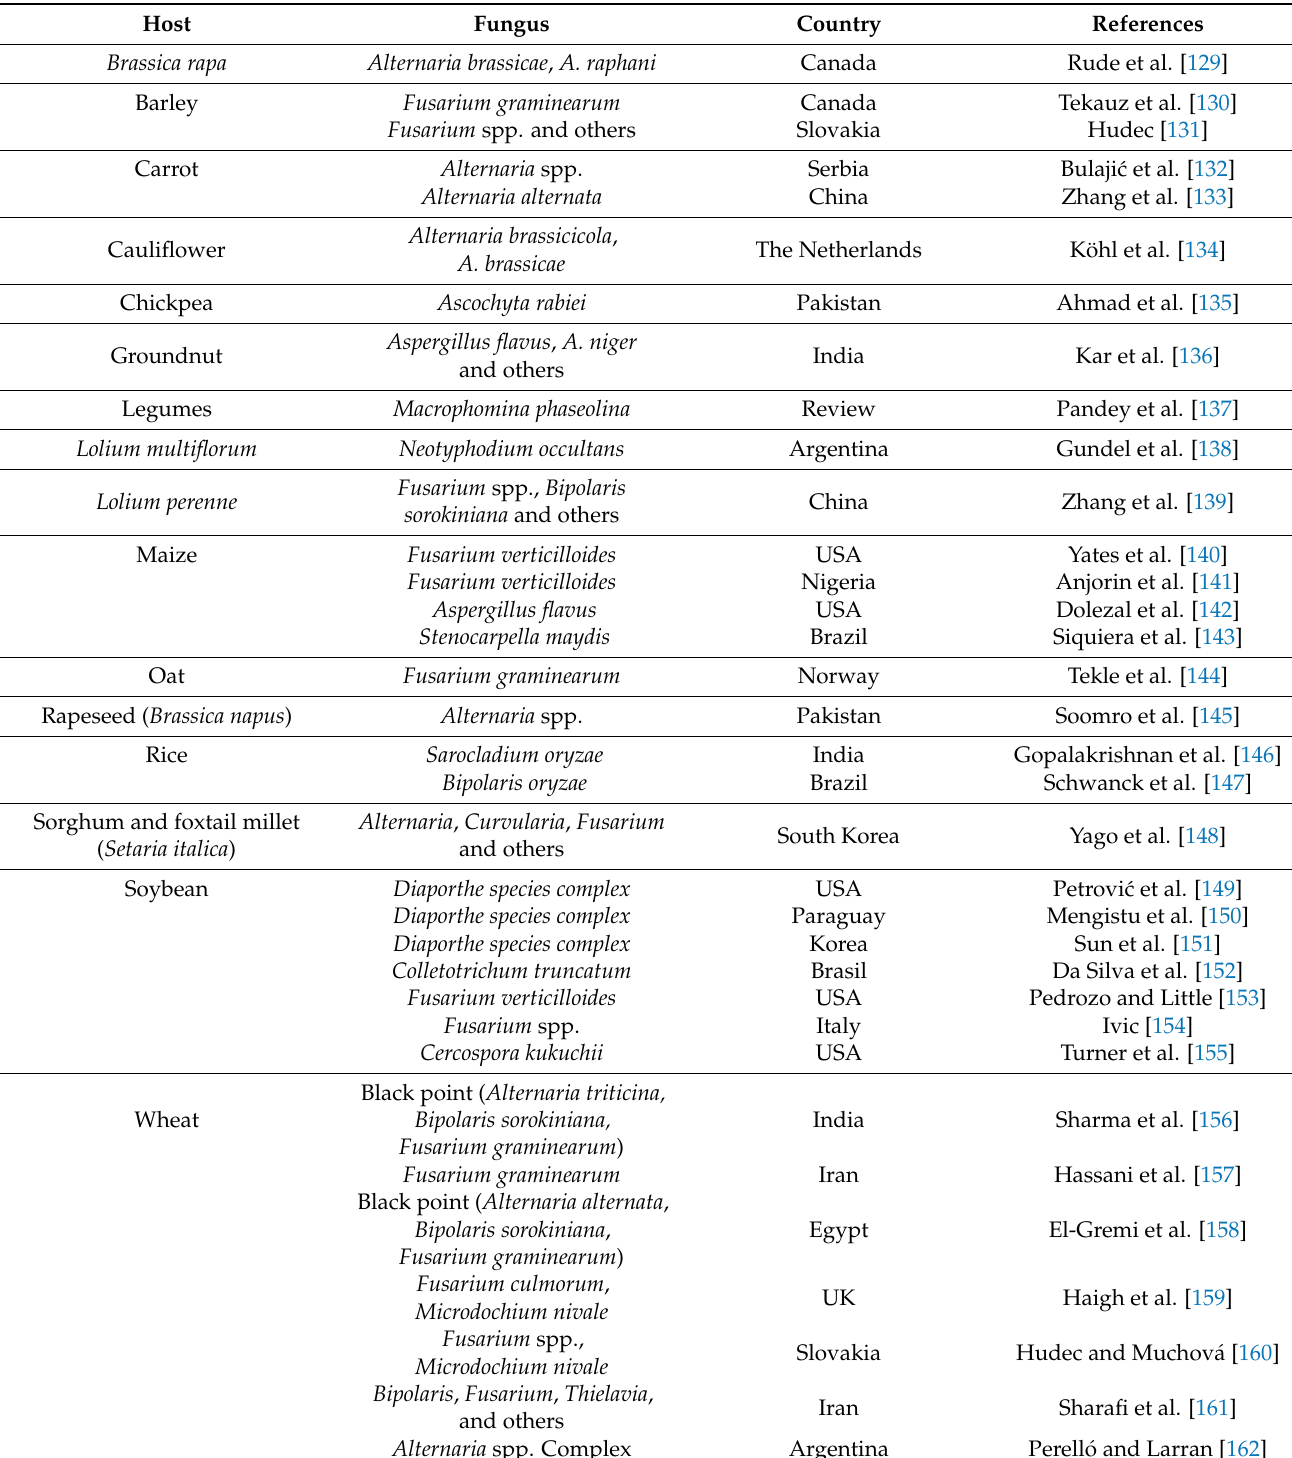
Table 3. Field fungi that affect seed viability and